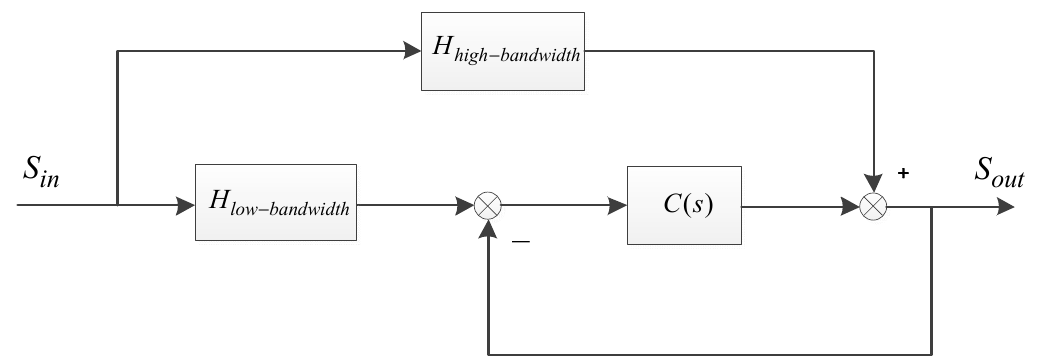
H − are low bandwidth ( ) C s is a